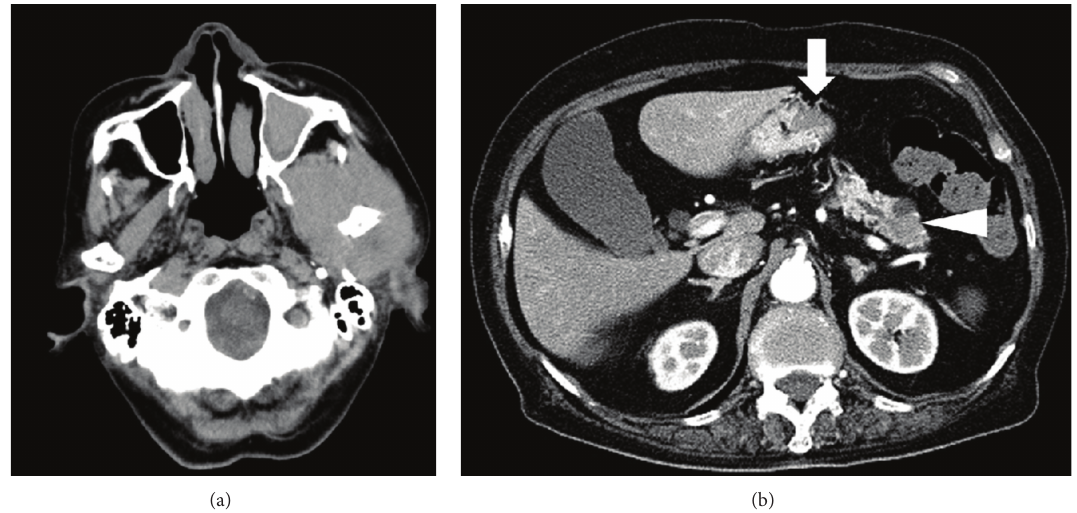
Figure 1: CT scanning images. A soft tissue density lesion 6cm in diameter in the left temporomandibular joint is shown (a). Multiple hypovascular tumors were also detected in the stomach (arrow) and the pancreas (arrowhead) (b).